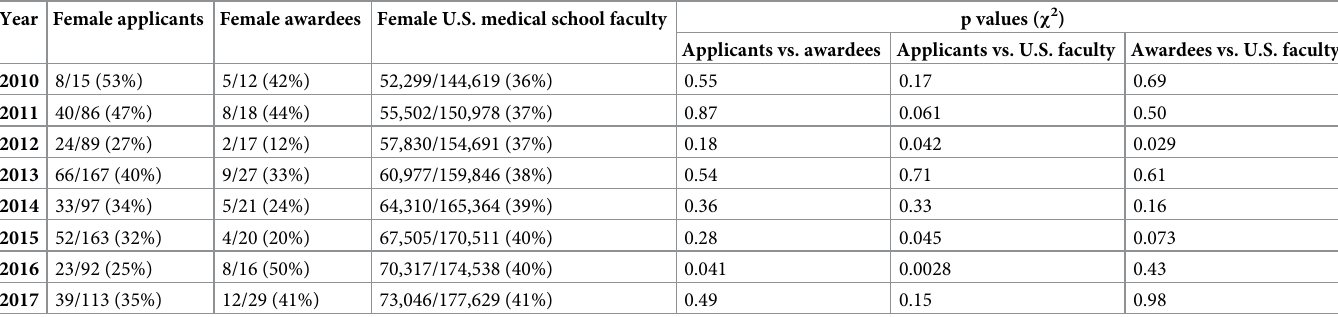
Table 2. Comparison of fraction of females among BRI grant applicants, BRI grant awardees, and U.S. medical school faculty by year, 2010–2017.